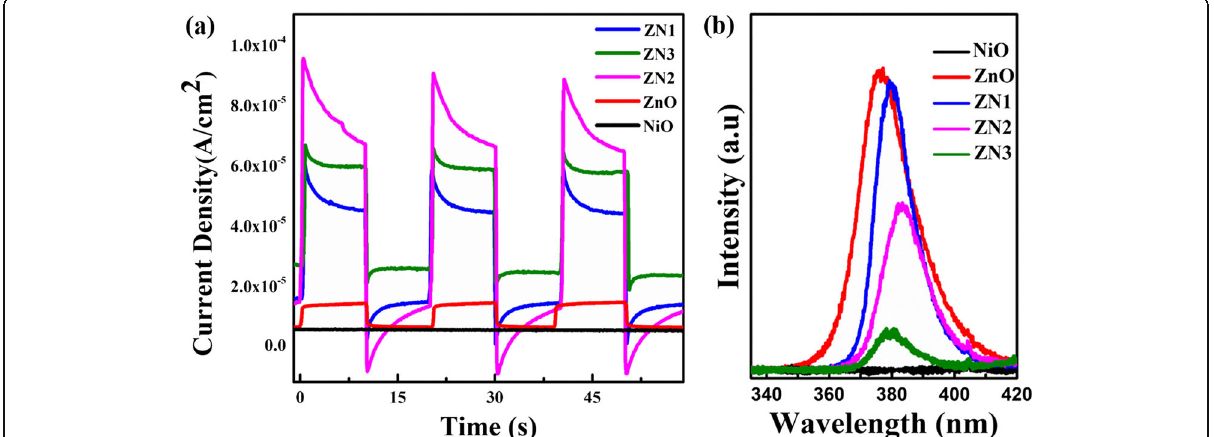
Fig. 8 a Photocurrent response of NiO nanosheets, ZnO nanorods, and ZnO@NiO heterostructure under UV lamp irradiation (10 W). b PL spectra of pure ZnO nanorods, NiO nanosheets, and ZnO@NiO composite